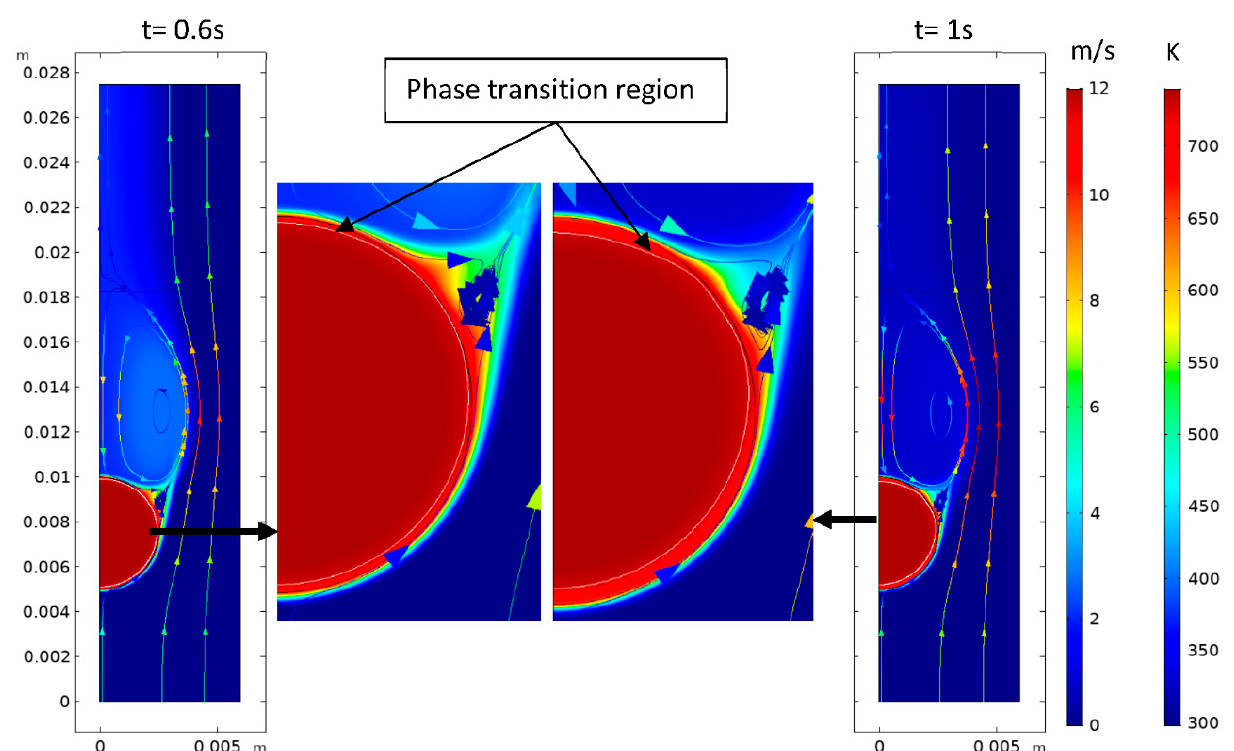
Figure 4. Temperature distribution of N 2 and the droplet (AgCl) domain with a droplet radius of 0.0025 m.